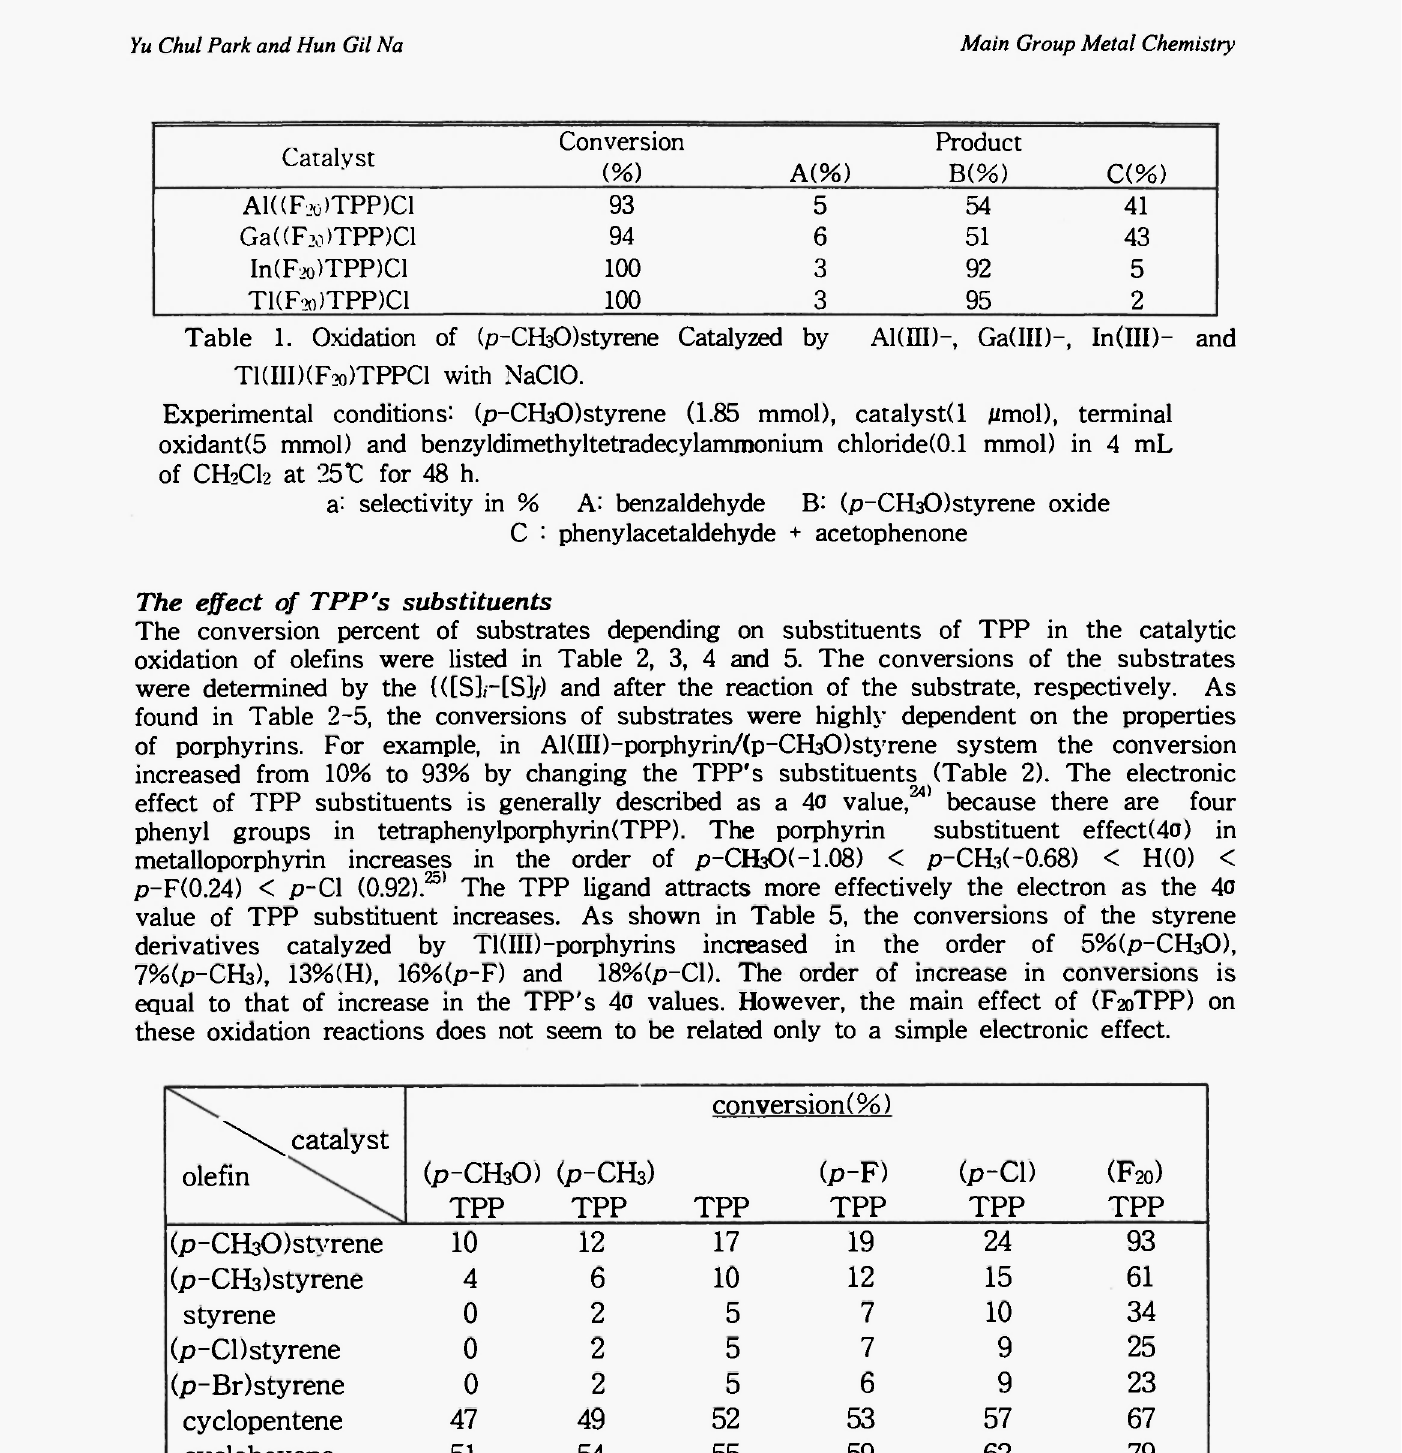
Table 2. Oxidation of Olefins Catalyzed by ClAHIIp-porphyrin Complexes with NaClO. Experimental conditions: olefin (1.85 mmol), catalystd /imol), terminal oxidant (5 mmol)